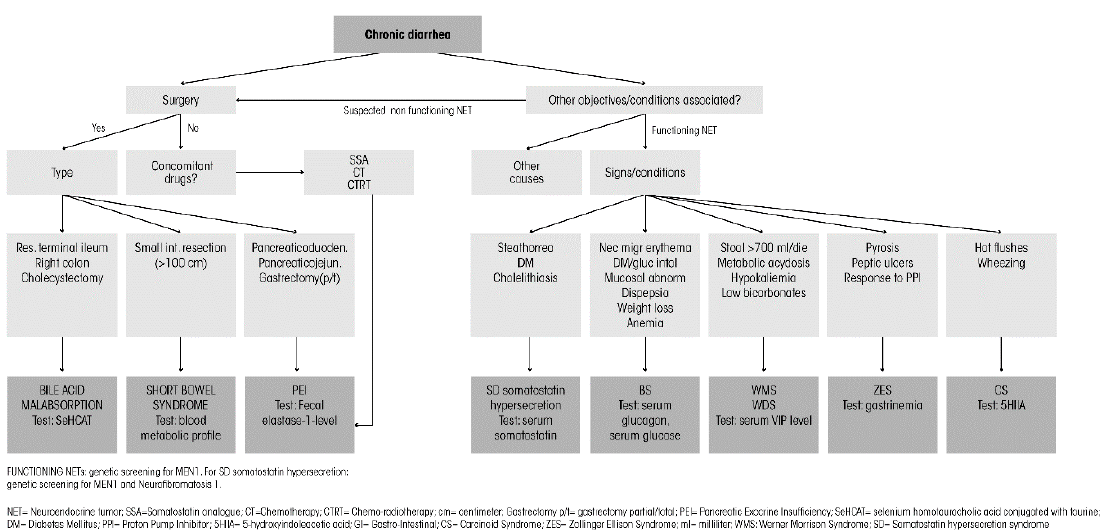
Figure 1. Differential diagnosis of chronic diarrhea in the case of a patient with a confirmed diagnosis of neuroendocrine tumor (NET).